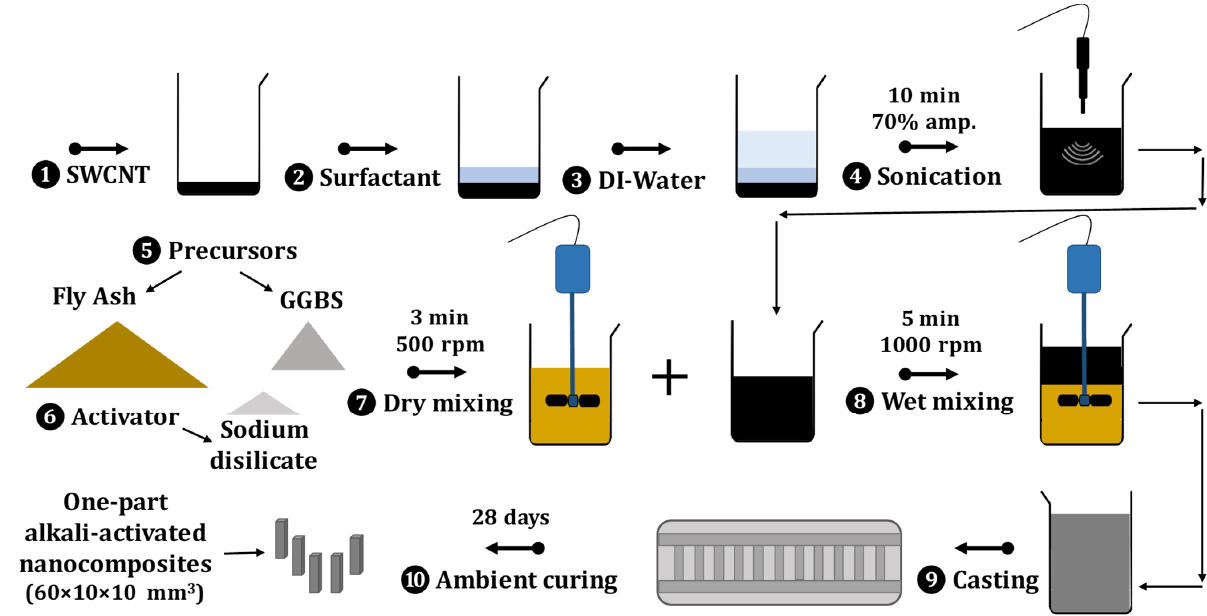
Figure 1. Schematic view of one-part SWCNT-alkali-activated nanocomposites’ synthesis in chemical laboratory scale.